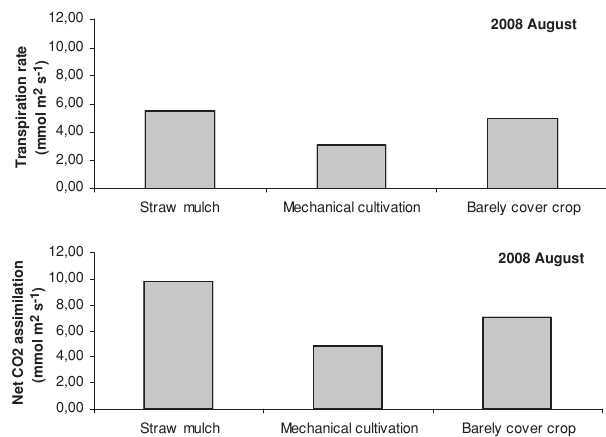
Figure3. Changes of the net CO 2 assimilation and transpiration rate on plots treated by different soil cultivation methods